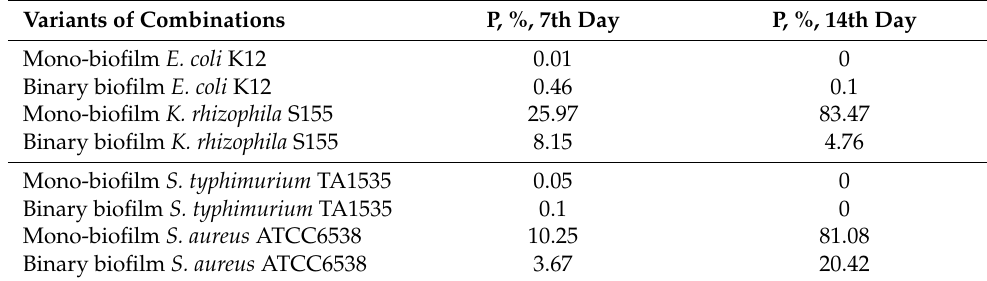
Table 3. Values of the persister (P) proportions (%) relative to the total number of cells (100%) in the mono-species and binary